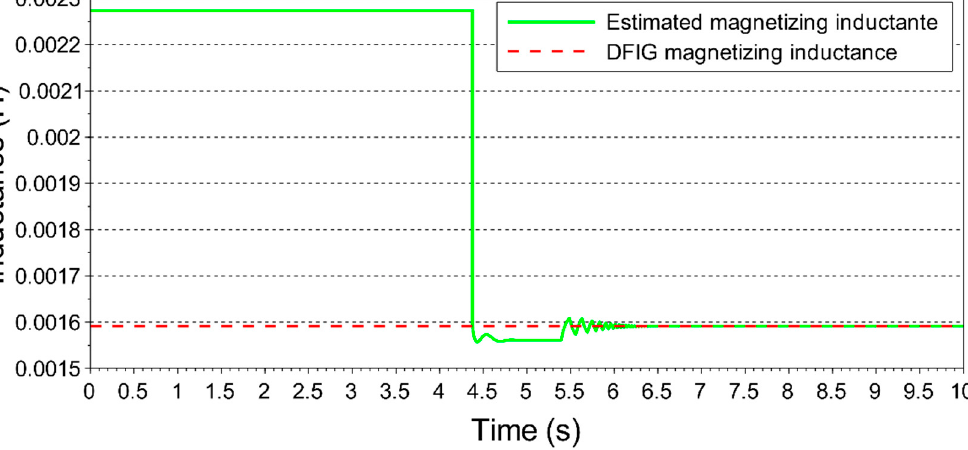
Figure 14. Correcting magnetizing inductance.